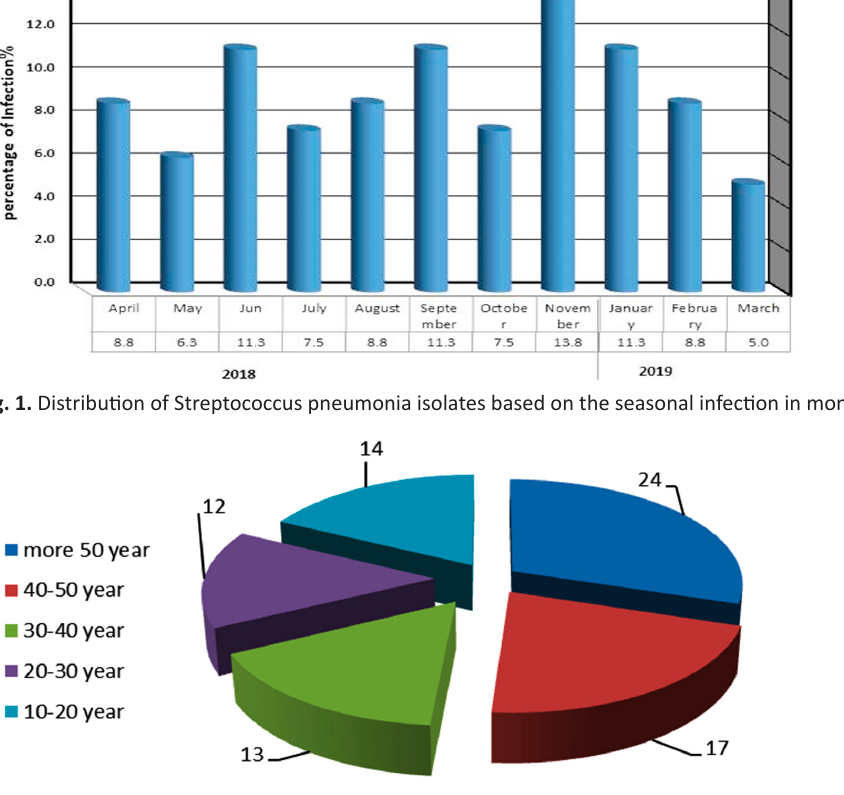
Fig. 2. Distribution of Streptococcus pneumonia infections based on patient